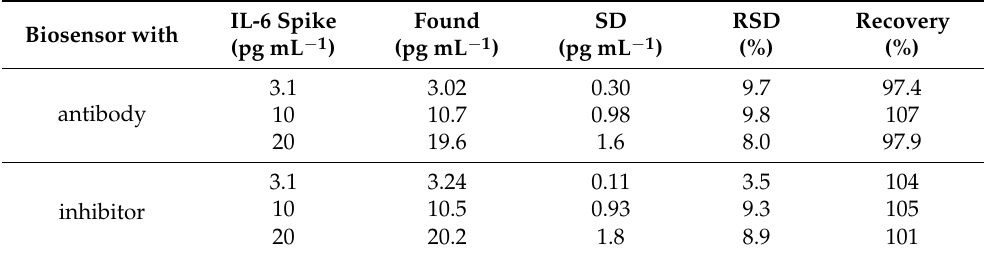
Table 3. Precision and recovery of the determination of IL-6 spikes by biosensor (a) and biosensor (i). Biosensor